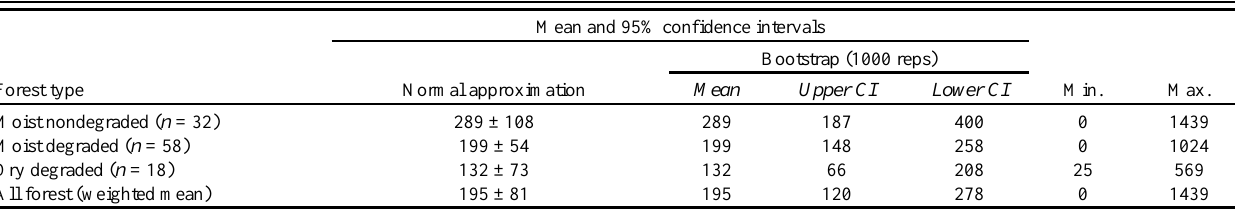
Table 3 . Bale Mountains forest carbon stock by forest type (tC/ha), comparing mean and confidence intervals between normal approximation and re-sampling with bootstrapped percentile confidence intervals.